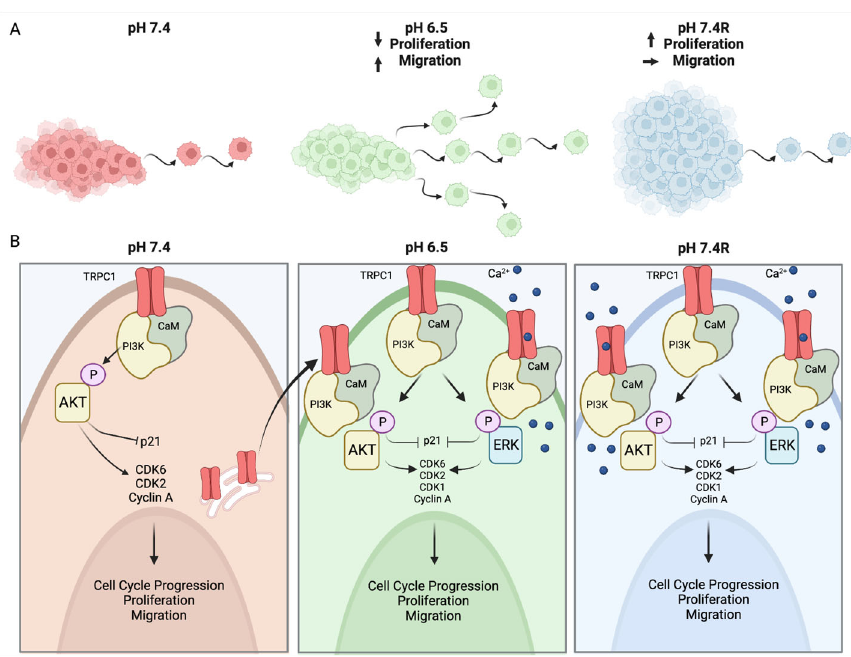
Figure 11. ( A ) Acid adaptation promotes migration but attenuates proliferation, whereas acid re ‐ covery impairs this migration but further accelerates proliferation. ( B ) The fluctuations in the acidic tumor microenvironment affect TRPC1 expression and localization. TRPC1 is downregulated in acid ‐ adapted PANC ‐ 1 cells and favors plasma membrane localization, which is maintained in acid ‐ recovered PANC ‐ 1 cells, where the expression of TRPC1 is upregulated. In the plasma membrane of acid ‐ adapted and ‐ recovered cells, TRPC1 permits Ca 2+ entry and, in interactions with the PI3K p85 α subunit and CaM, regulates PANC ‐ 1 cell migration, proliferation, and cell cycle progression. The figure is generated with www.Biorender.com.